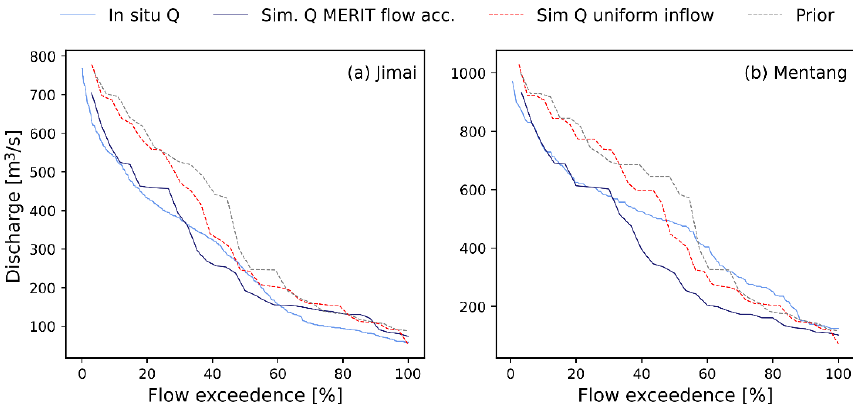
Figure 11. Simulated discharge vs. in situ measured discharge at Jimai (a) and Mentang (b)